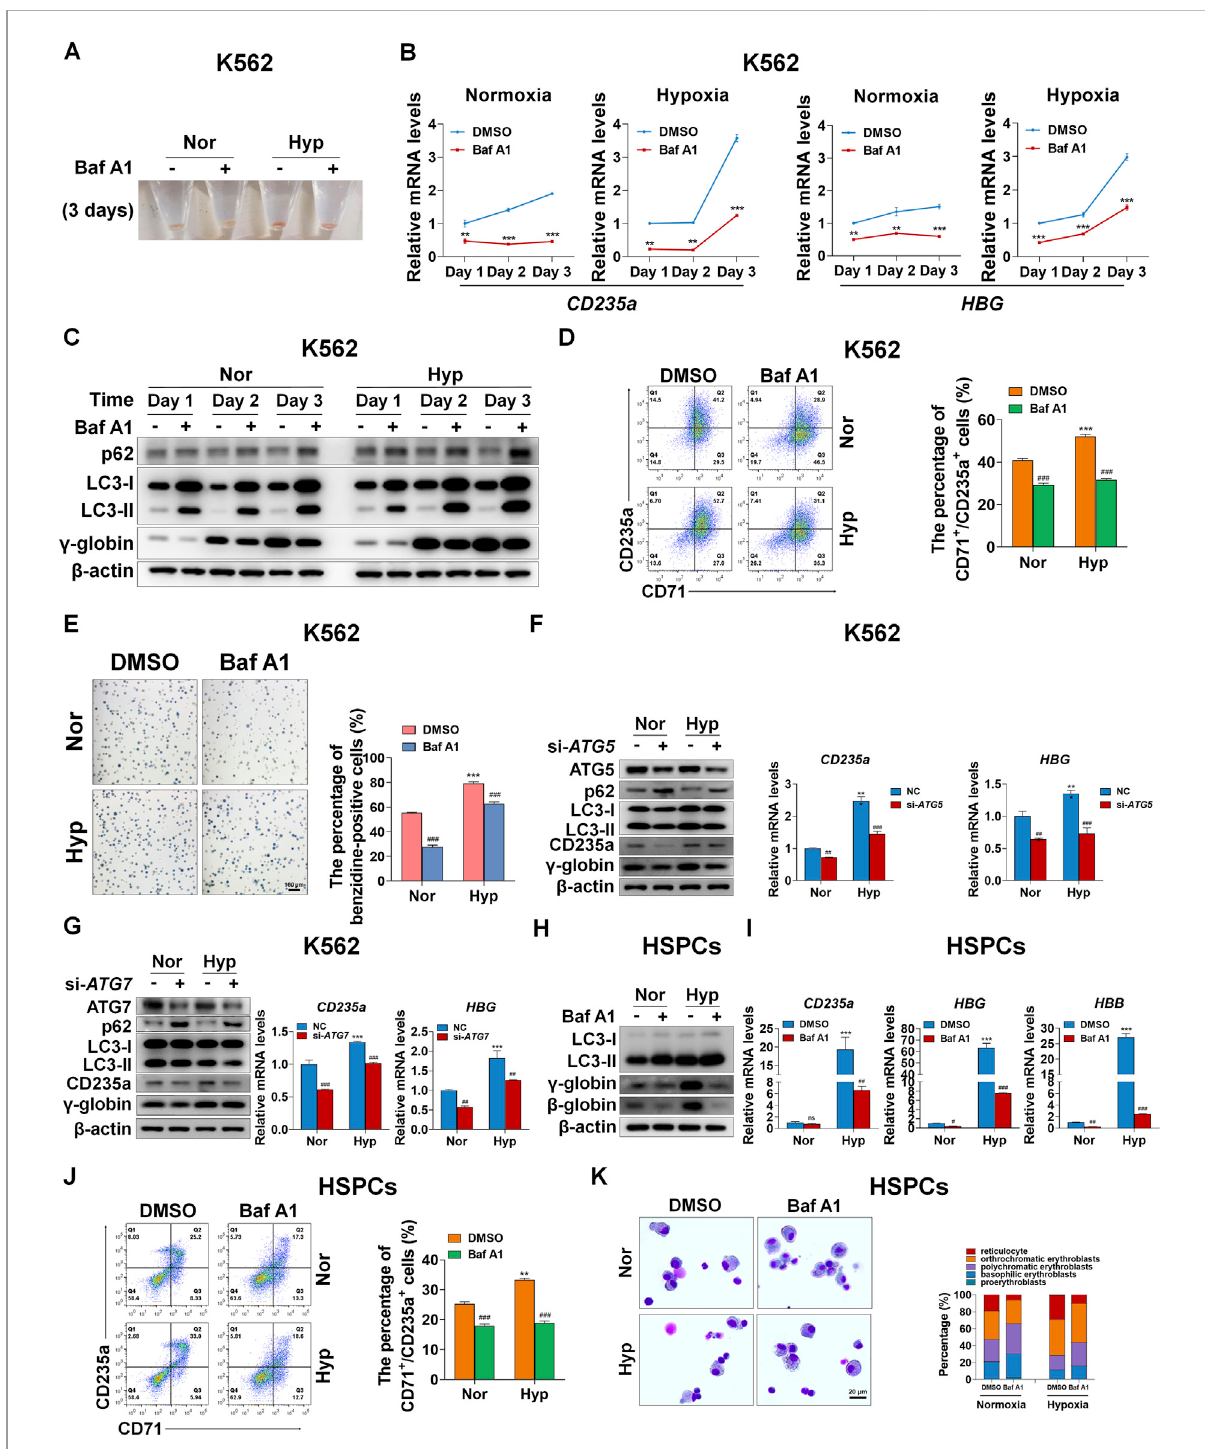
FIGURE 3 Autophagymediateserythroiddifferentiationpromotedbyhypoxia (A) ReddishpelletsofK562cellsdifferentiatedintoerythrocytestreatedwith DMSO or Baf A1 (20 nM) under normoxia and hypoxia. The red color of pellets was lightened by Baf A1 in both normoxia and hypoxia (B) qRT-PCR analysis of the relative mRNA levels of CD235a and HBG at the indicated time points after K562 cells treated with DMSO (-) as control or Baf A1 (+, 20 nM) were induced into erythroid differentiation under normoxia or hypoxia conditions. ** p < 0.01; *** p < 0.001. versus the respective normoxia group at different time points (C) Western blot analysis of p62, LC3 and γ -globin protein expression at the indicated time points after K562 cells differentiated into erythrocytes were treated with DMSO (-) as control or Baf A1 (+, 20 nM) under normoxia or hypoxia. Nor: normoxia;